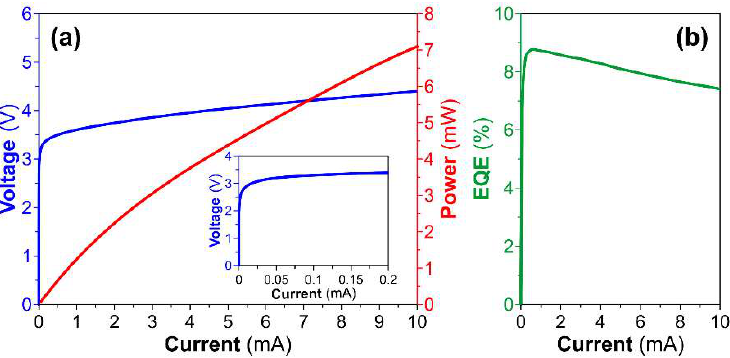
Figure 4. ( a ) Measured light–current–voltage curve and ( b ) external quantum efficiency of the fabricated InGaN-based green µ-PCLED with a mesa diameter of 30 µm. The inset in Figure 4a shows the zoom-in picture of I-V curve.